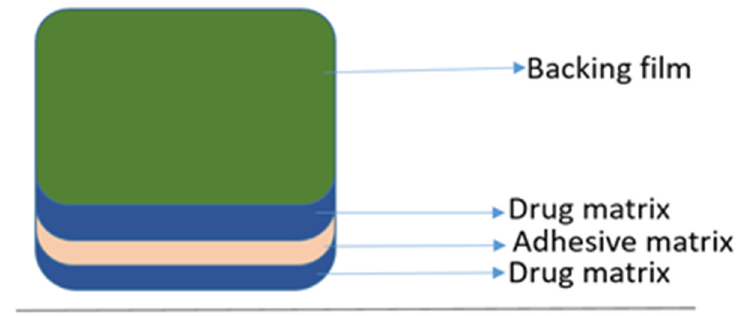
Figure 2. Rivastigmine